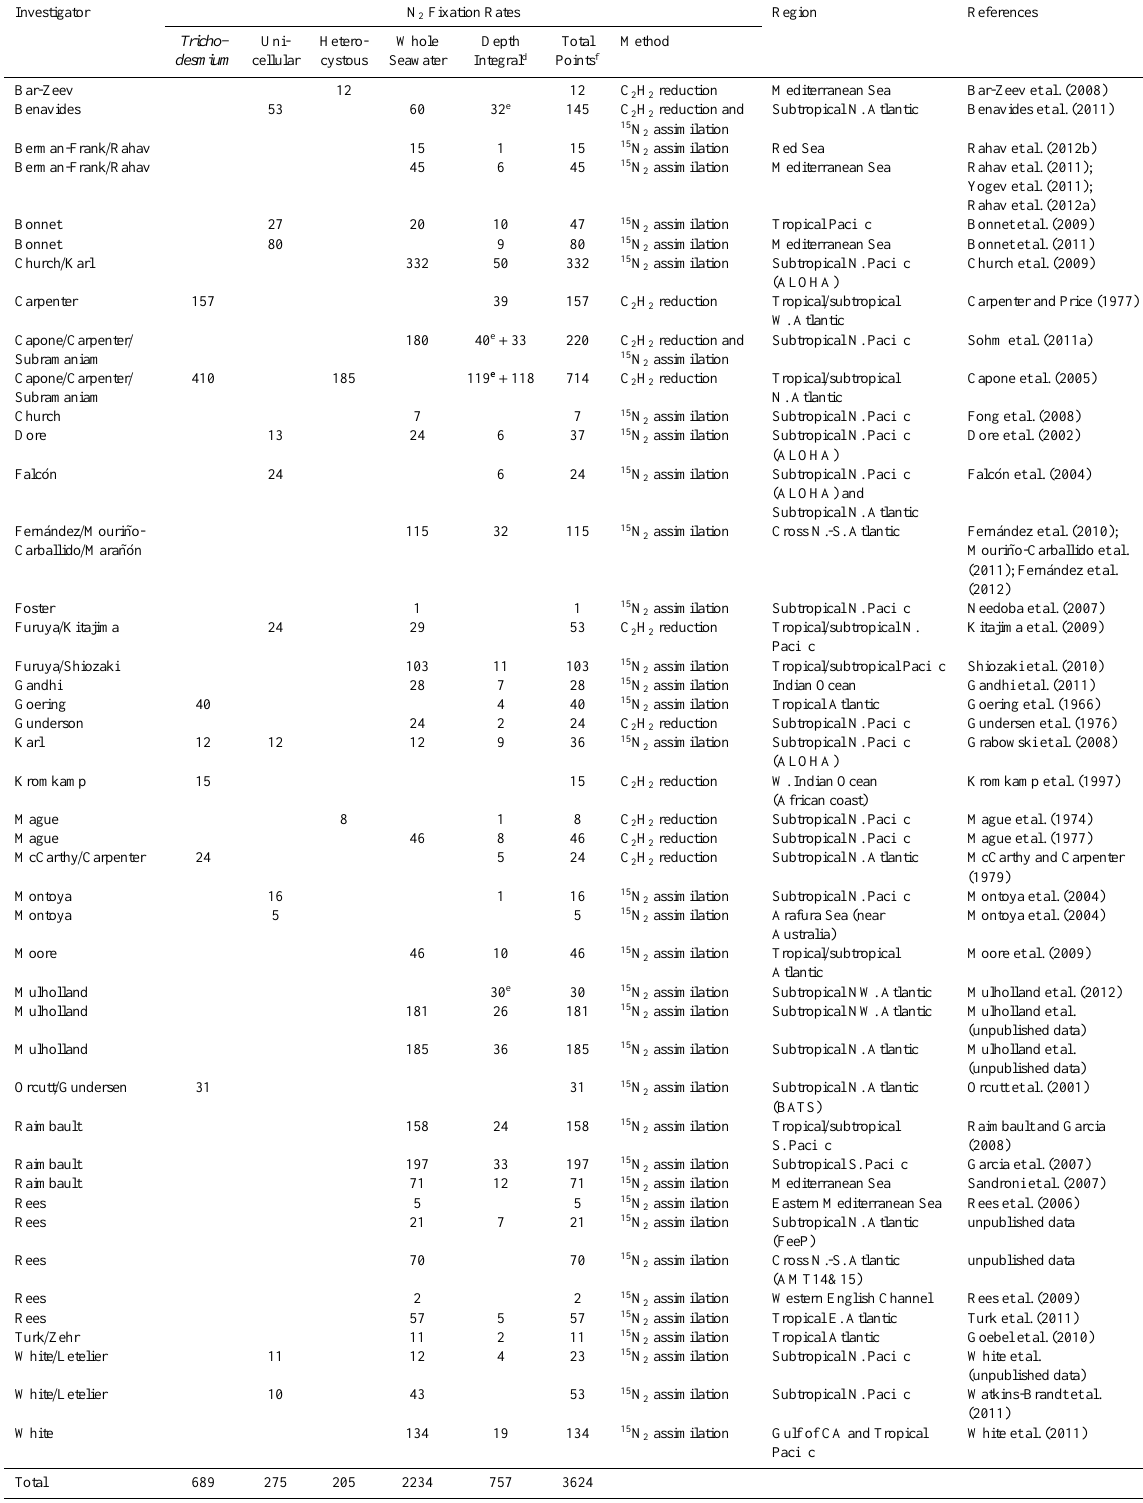
Table 1b. Summary of data points for N 2 fixation rates, including volumetric measurements of Trichodesmium , unicellular cyanobacteria and heterocystous cyanobacteria and their